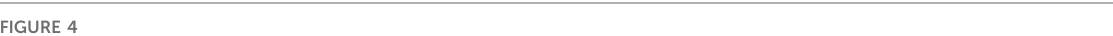
FIGURE 4 40x, scale bar 20 µm. The picture is representative of 3 different experiments. (C) Video analysis of the muscle cell contractions in single culture of myotubes, in a contacting co-culture (hAFSC-derived MNs plus myotube) and in a non-contacting co-culture between hAFSC-derived MNs